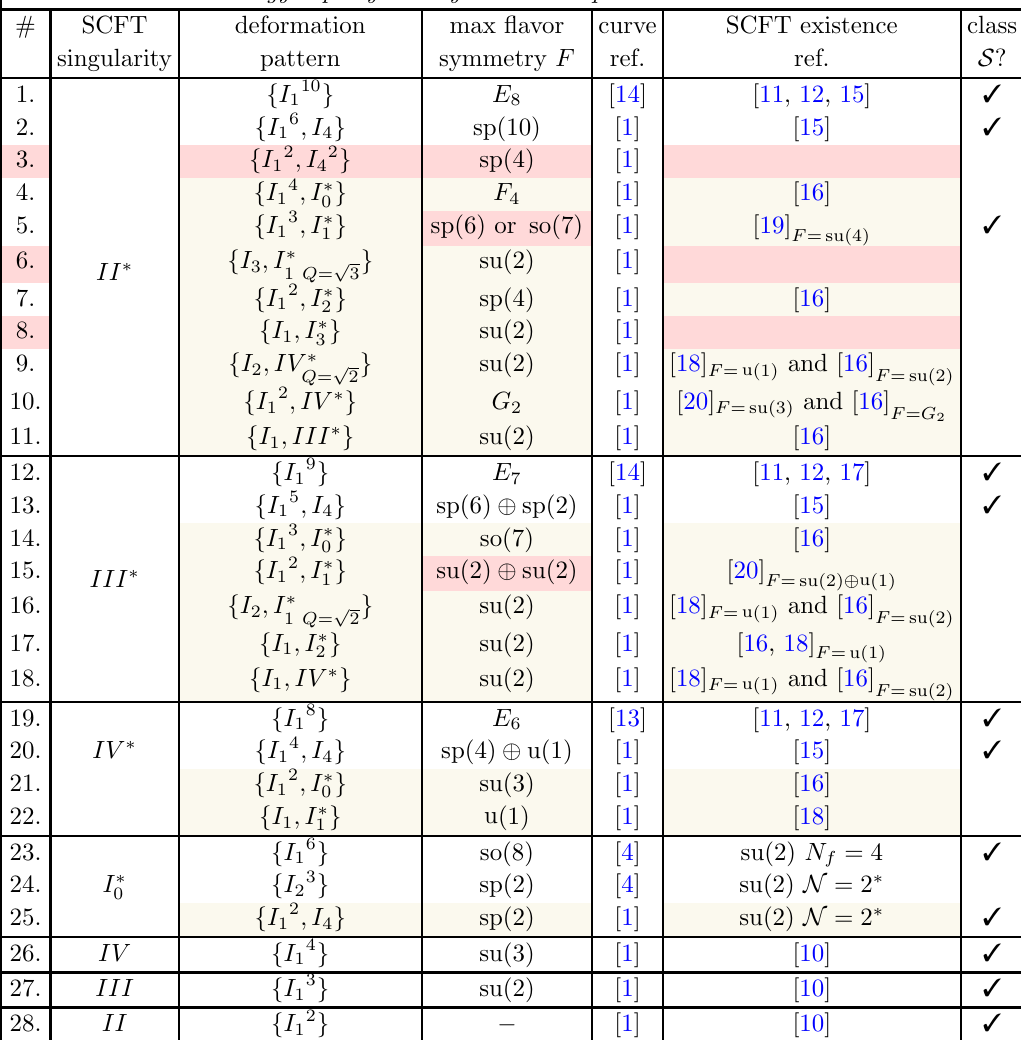
Table 1 . The 28 families of deformed planar rank-1 CB geometries consistent with the low energy Dirac quantization condition. Column 2 lists the Kodaira type of the scale invariant CB